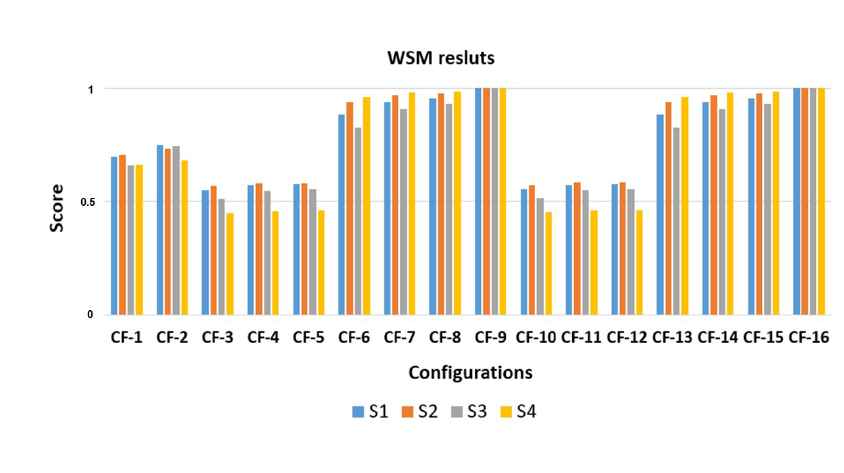
Figure 10. Illustrative results obtained by WSM method.